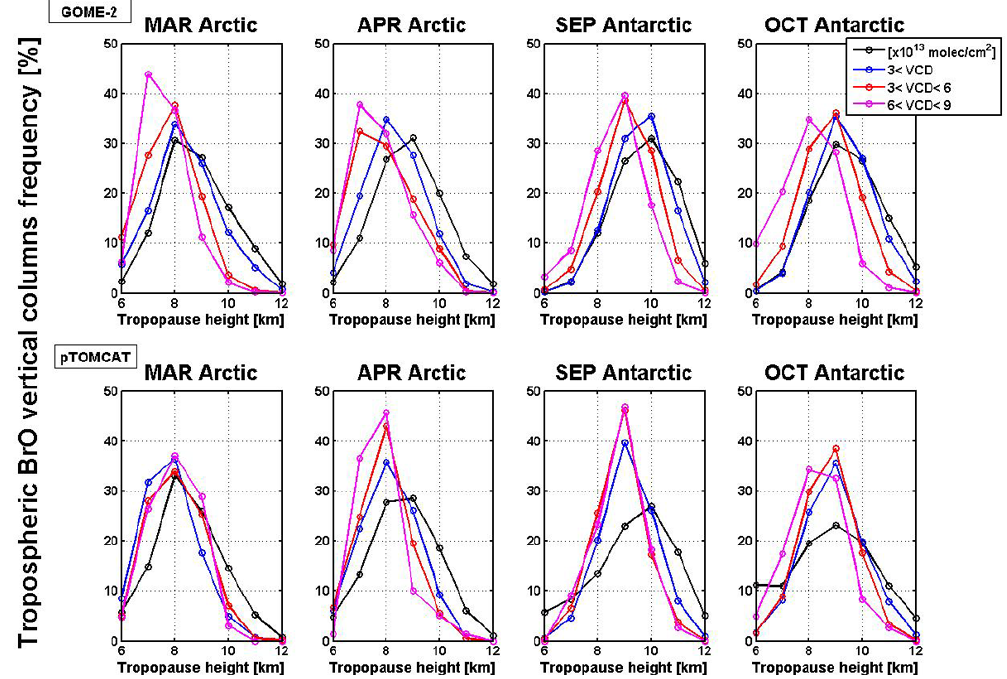
Fig. 12. Frequency distribution (expressed in %) of the GOME-2 (upper row) and p -TOMCAT (lower row) tropospheric BrO vertical columns as a function of the altitude of the tropopause ( ± 0.5km), for different ranges of vertical columns. The results are shown separately for different months in spring in the Northern Hemisphere (55–90 ◦ N; March and April) and Southern hemisphere (55–75 ◦ S; September and October). Only data corresponding to solar zenith angles lower than 80 ◦ are considered